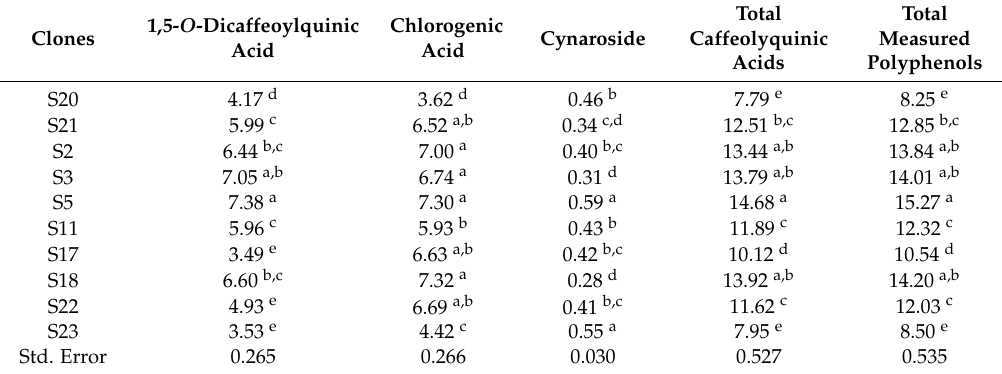
Table 5. Biochemical characterization (in g·kg − 1 DM) of the heads of the 10 Romanesco clones.